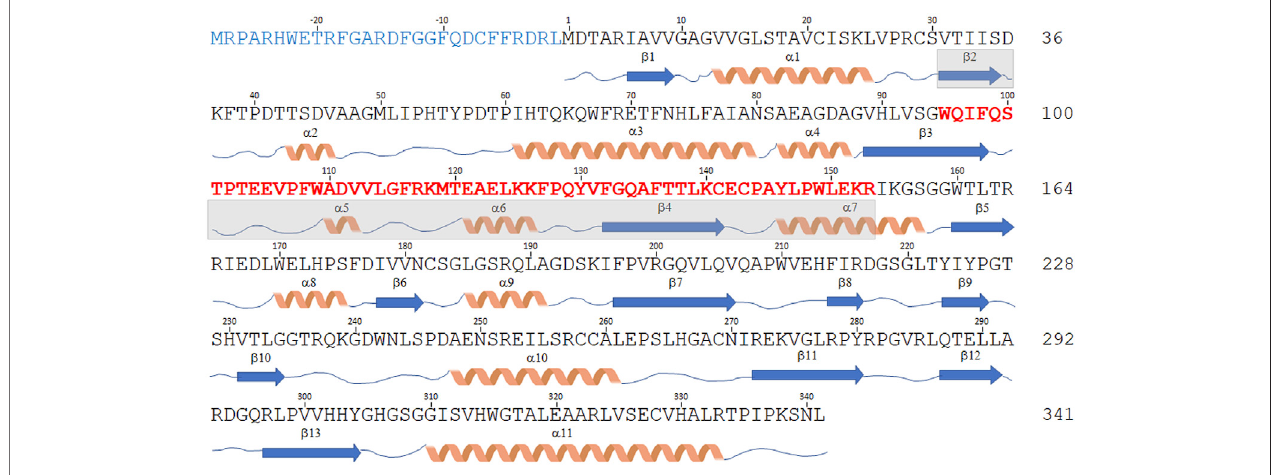
FIGURE 3 | Sequence comparison of hDASPO isoforms. Schematic representation of the amino acid sequence of the hDASPO isoforms reported in the UniProtKB/Swiss-Prot database. The secondary structure elements (as determined for the canonical hDASPO_341) are reported below. The N-terminal 28 additional residues of the hDASPO_369 isoform are depicted in blue. The 59 amino acids long portion of the protein lacking in the hDASPO_282 isoform are depicted in bold red (and the corresponding secondary structure elements are shaded in